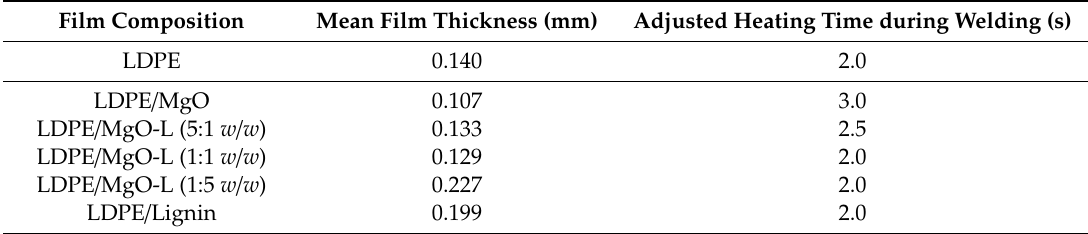
Table 3. Welding conditions applied to achieve welded joint of extruded films.